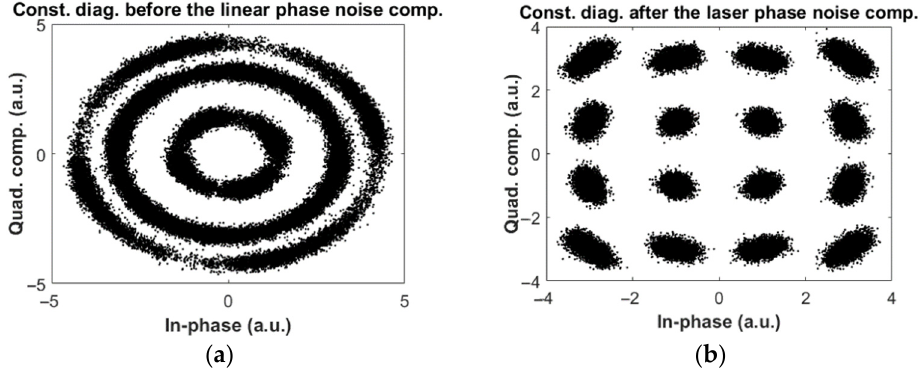
Figure 6. Example of received constellation diagram for QAM-16 in FSO coherent system (downlink), ( a ) before phase noise compensation, and ( b ) after phase noise compensation.